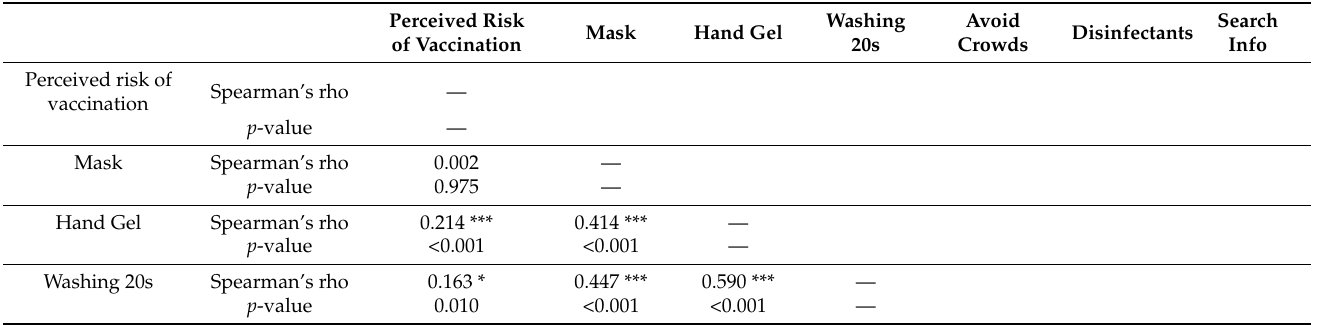
Table 8. Correlation matrix of preventive behaviors and risk perception about